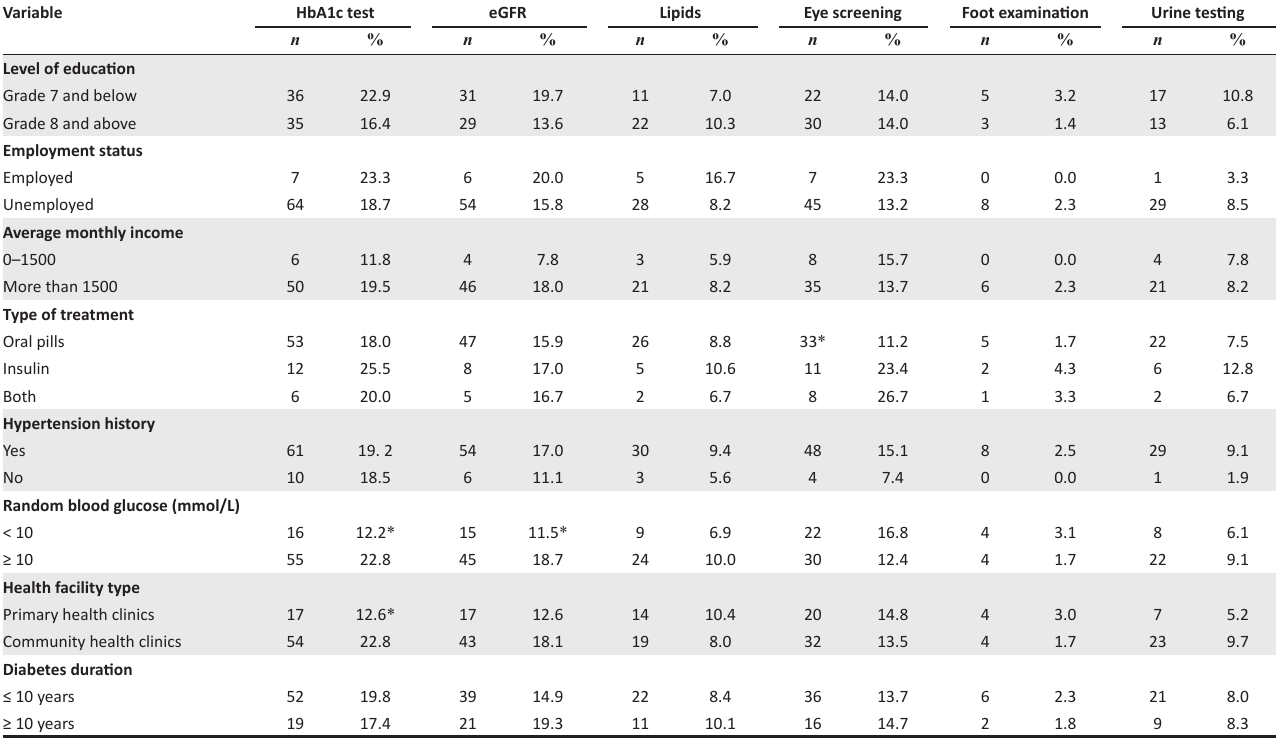
TABLE 3: Screening for complications stratified by demographic and clinical